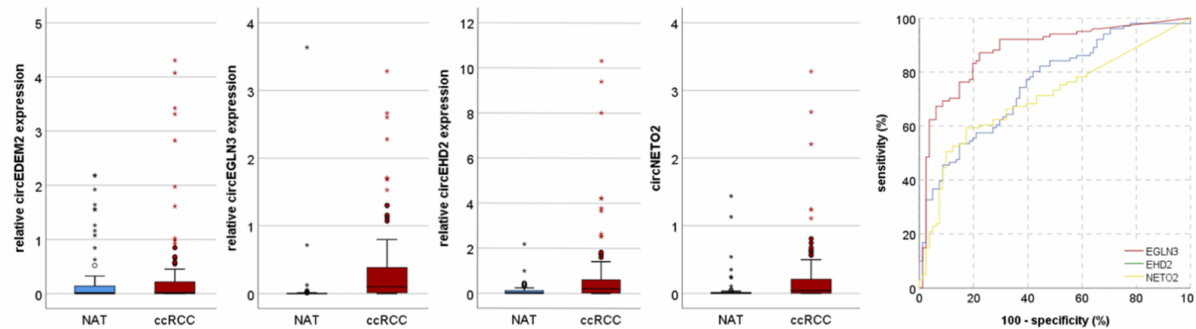
Figure 2. The expression of circEHD2 ( p < 0.001), circEGLN3 ( p < 0.001), and circNETO2 ( p < 0.001) is increased in clear cell renal cell carcinoma (ccRCC) compared with normal renal (NAT) tissues. The Receiver Operator Characteristic analysis demonstrates that circEGLN3 allows discrimination of NAT and ccRCC with high accuracy. Circles indicate outliers, asterixis extreme